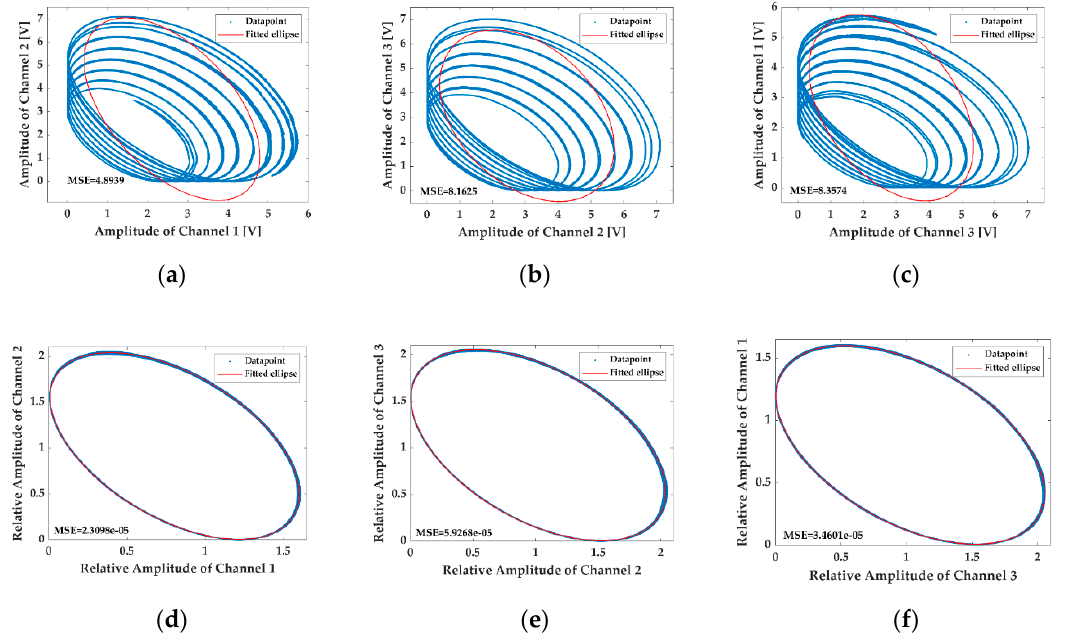
Figure 7. The LFs drawn with the interferometric signals on the frequency modulation (FM) condition of f m = 500 Hz and C = 24 before ( a – c ) and after ( d – f ) removing the influence of AAM by the proposed method.